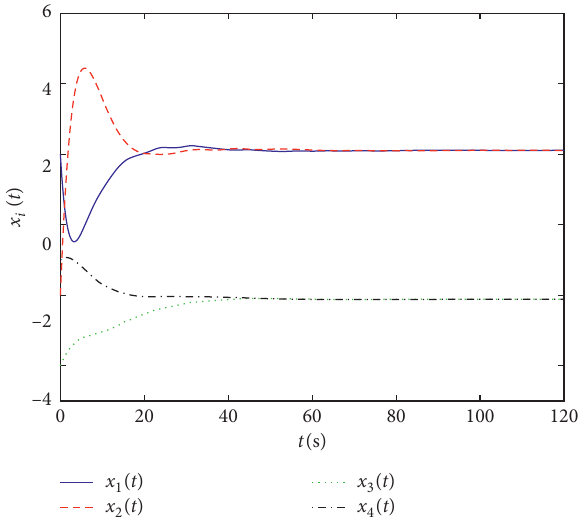
Figure 2: The position trajectory of each agent when τ � 0.